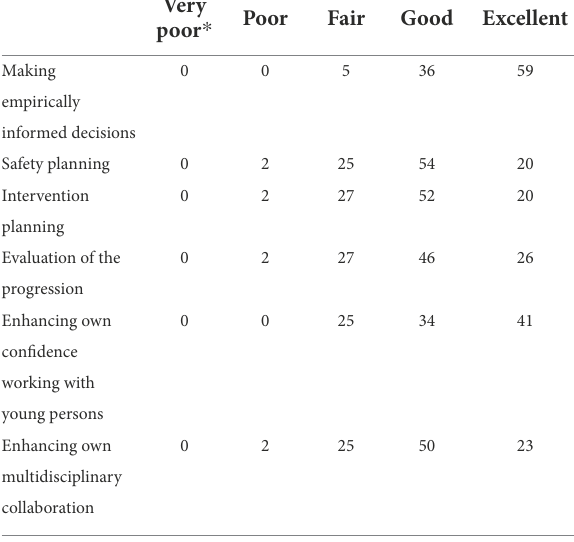
TABLE 3 The participants’ experience of the AIM3